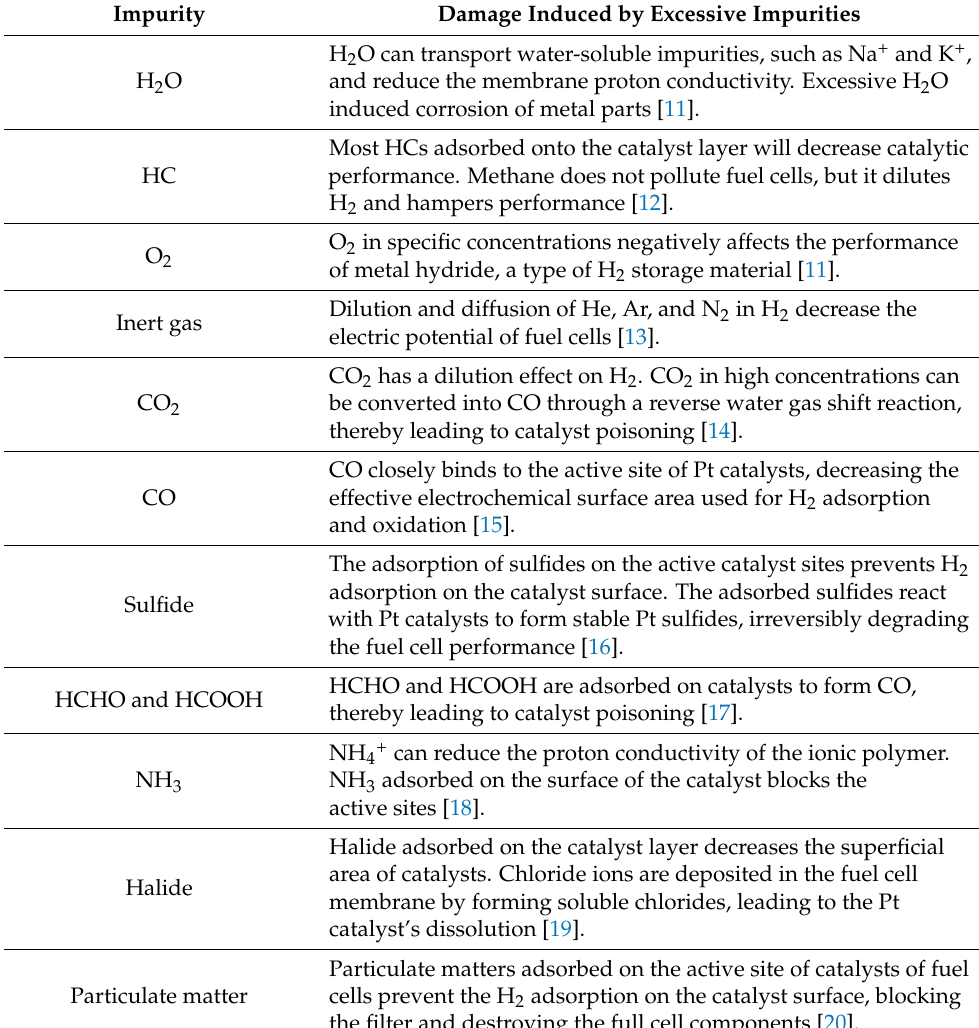
Table 3. Impact of impurities on the performance of fuel